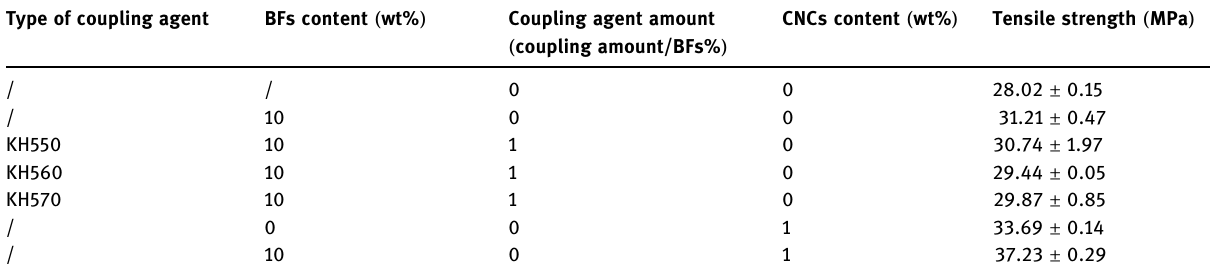
Table 1: Comparison of the e ff ects of coupling agent and CNCs on the tensile strength of composites Type of coupling agent